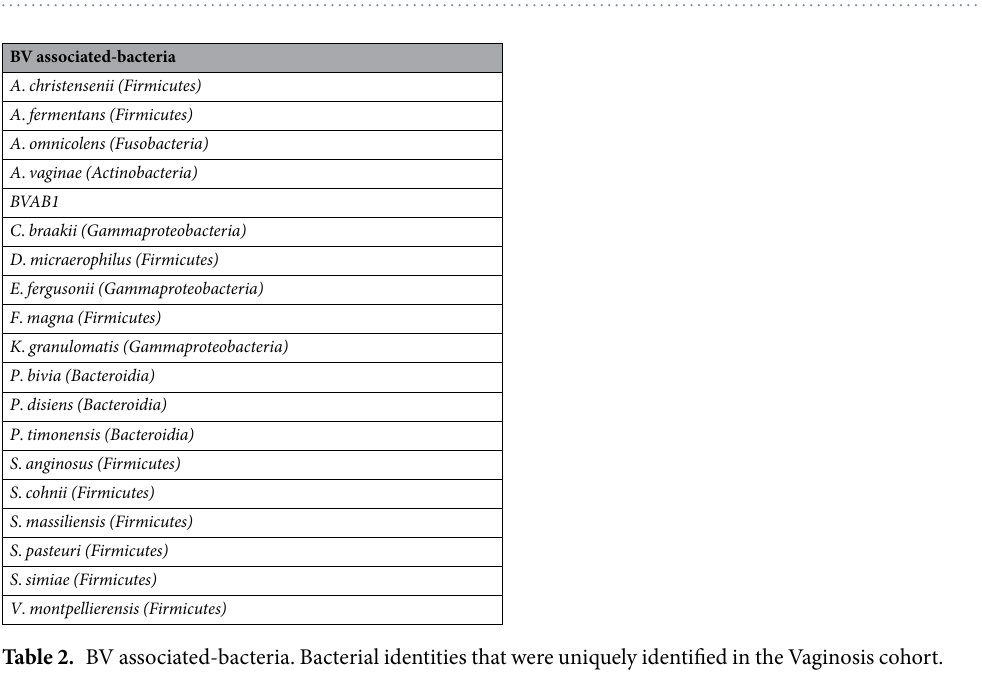
Figure 1. The vaginal bacterial communities from patients with eubiotic and dysbiotic microbiota. The output of plot_taxa_summary.py of QIIME showing the relative abundance of the 33 predominant bacterial taxonomic groups, in alphabetical order, in the studied cohorts: Healthy (Nugent score 0–3), Intermediate (Nugent score 4–6) and Vaginosis (Nugent score 7–10).